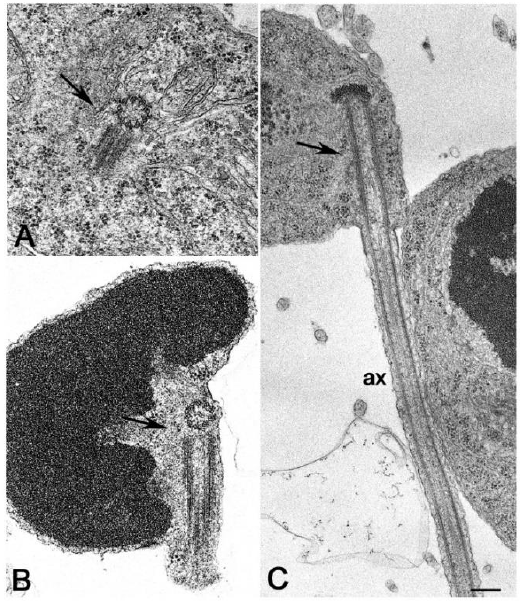
Figure 2. Abnormal male gametogenesis in the springtail Allacma . (A) Detail of one of the two centriole pairs in young primary spermatocytes. (B) Degenerating germ cell with two centrioles. (C) Spermatid with one centriole nucleating a functional axoneme (ax). Arrows point to centrioles. Bar: 200 nm.